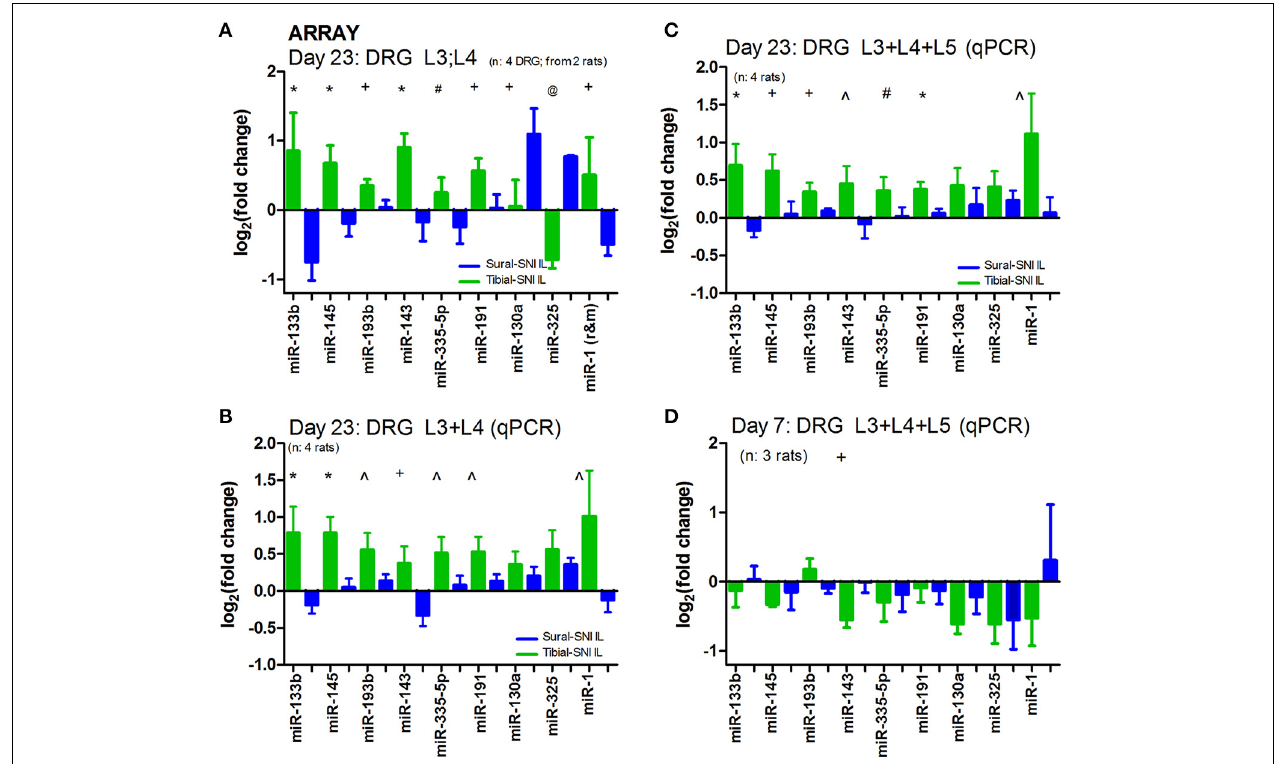
FIGURE 3 | In ipsilateral DRG seven miRs are differentially regulated between Sural-SNI and Tibial-SNI. (A) By using a microarray chip containing probes for detecting 375 miRs, we found that only nine miRs were differentially regulated in IL DRG between Sural-SNI and Tibial-SNI at Day 23. Ct values were < 30.60 for miR-133b, < 27.78 for miR-145, < 27.66 for miR-193b, < 30.19 for miR-143, < 33.69 for miR-335, < 23.42 for miR-191, < 37.89 for miR-130a, < 36.00 for miR-325, < 32.04 for miR-1. Reference miRs were: MammU6-4395470 (Ct values < 19.30), snoRNA135-4380912 (Ct values < 33.98), and U87-4386735 (Ct values < 28.32). The n value was four DRG (two L3 and two L4). For each SNI-group, the mean value from four individual DRG (two L3-DRG and two L4 DRG) were used. (B,C) By using qPCR it was confirmed that seven out of the initially identified nine miRs (in A ) were differentially regulated in IL DRG between Sural-SNI and Tibial SNI at